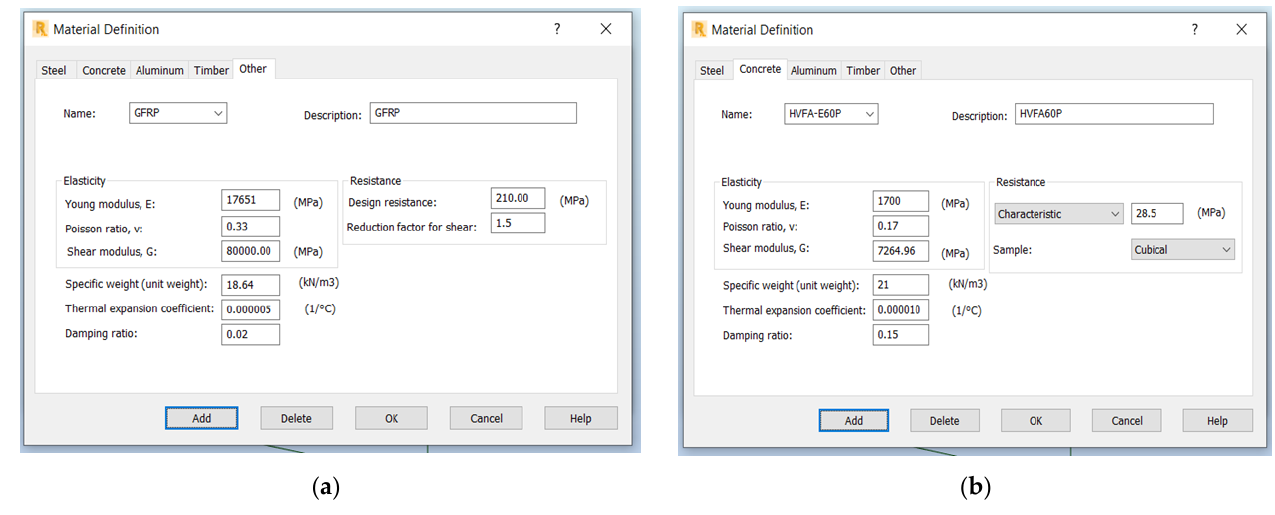
Figure 15. Material properties used in the FE model. ( a ) GFRP; ( b ) HVFA-ECC.